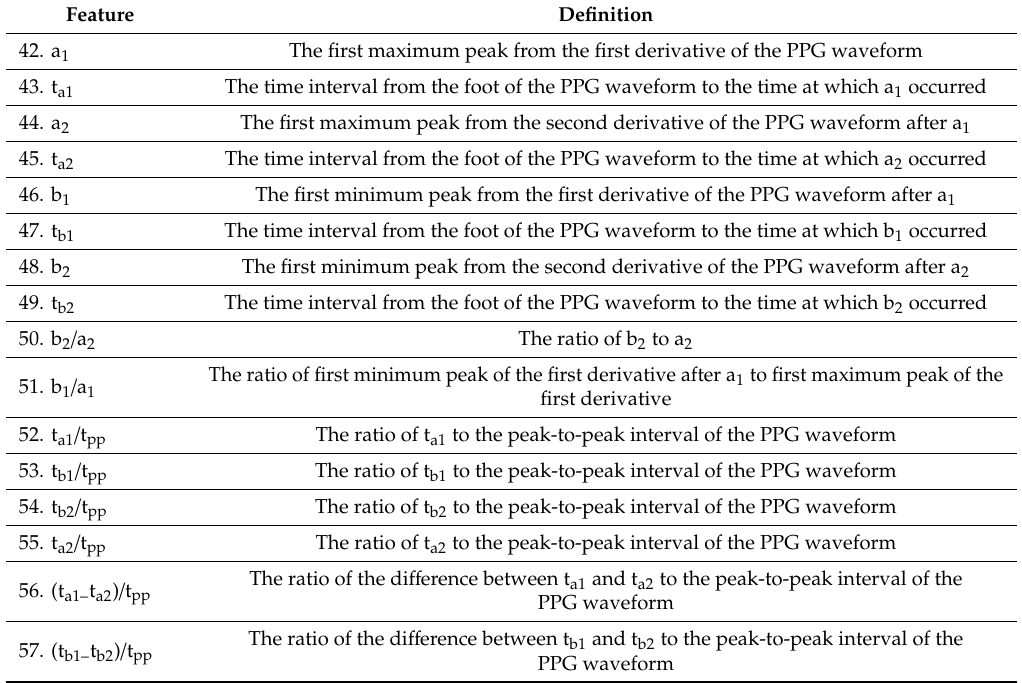
Table 4. Sixteen features derived from the first and second derivative.